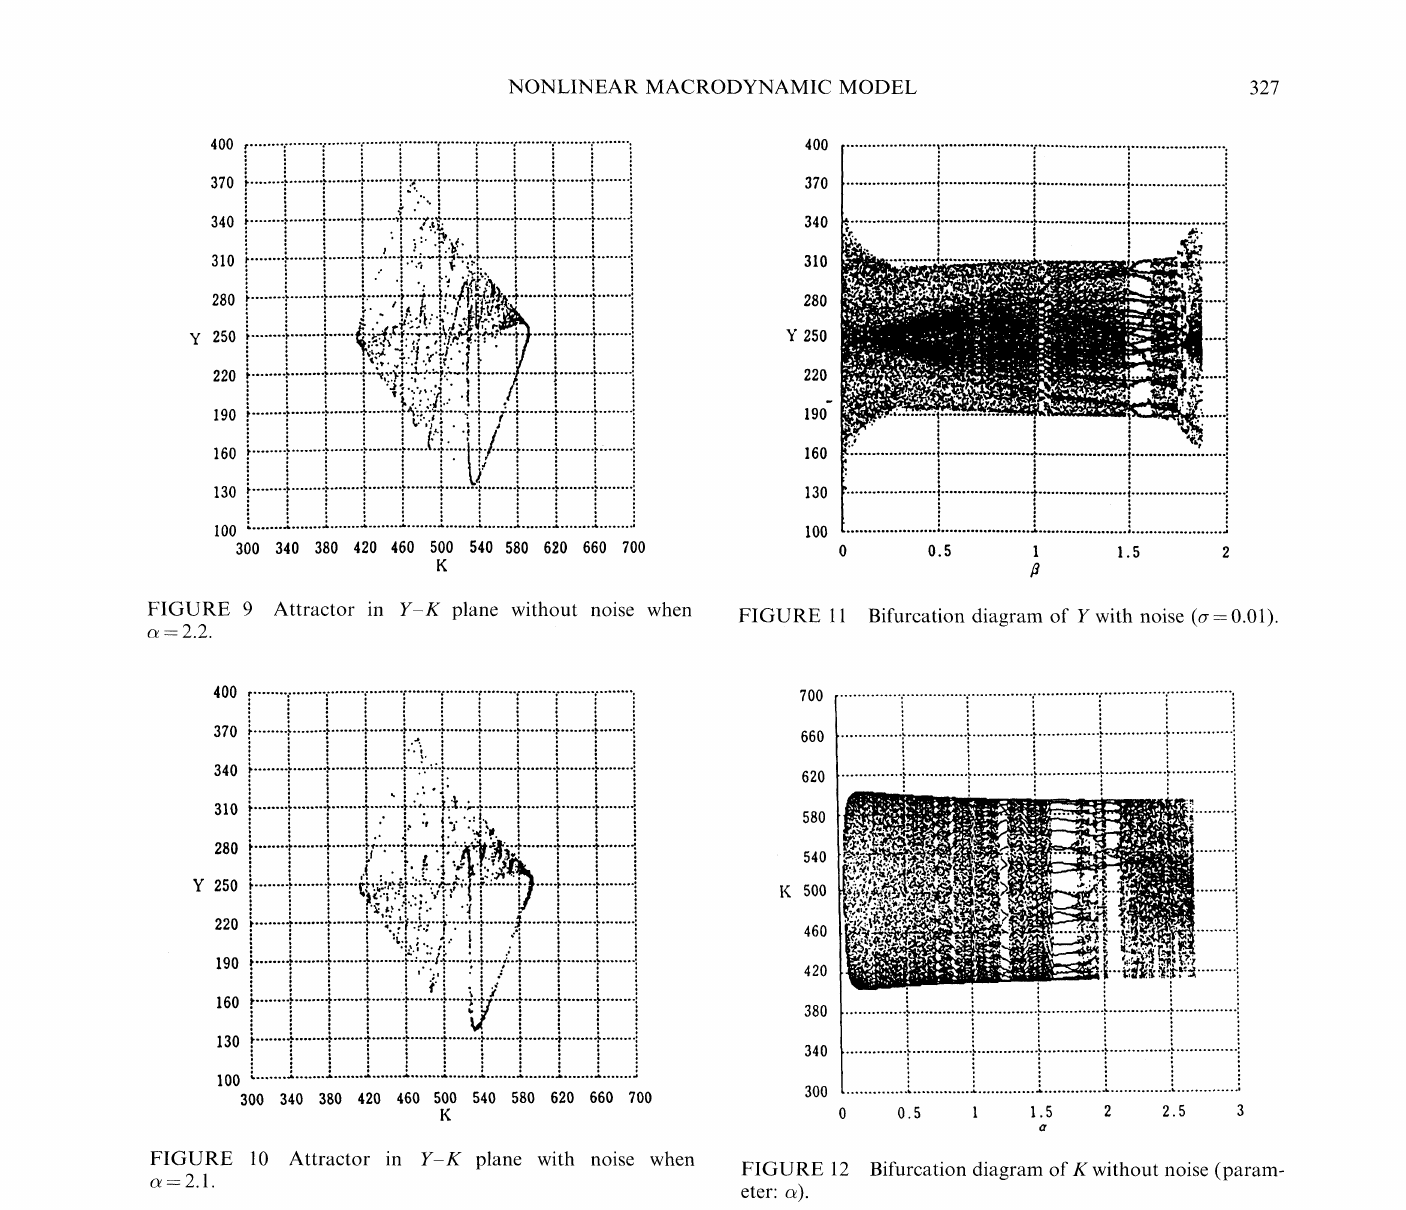
FIGURE 10 Attractor in Y-K plane with noise when oe=2.1.